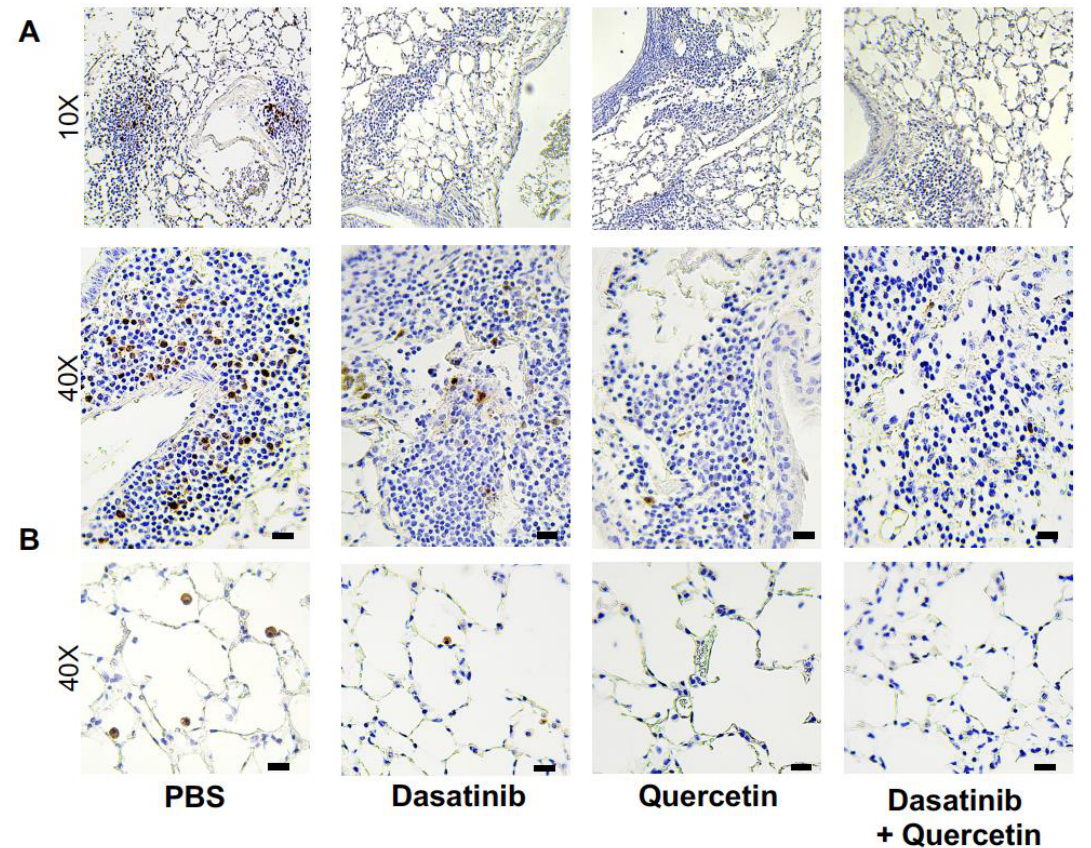
Figure 2. Treatment of Aged Mice with Senolytics Reduces p16 Expression in Lung. Lung tissue was collected from PBS-, quercetin-, dasatinib-, and quercetin + dasatinib-treated aged adult BALB/c mice (20 months of age). Immunohistochemical staining for p16 was performed on lung tissue sections and representative images were collected. ( A ) 10× and 40× images of lung lymphoid tissue and ( B ) alveolar space were observed. N = 6 mice per group. Bar represents 25 M.